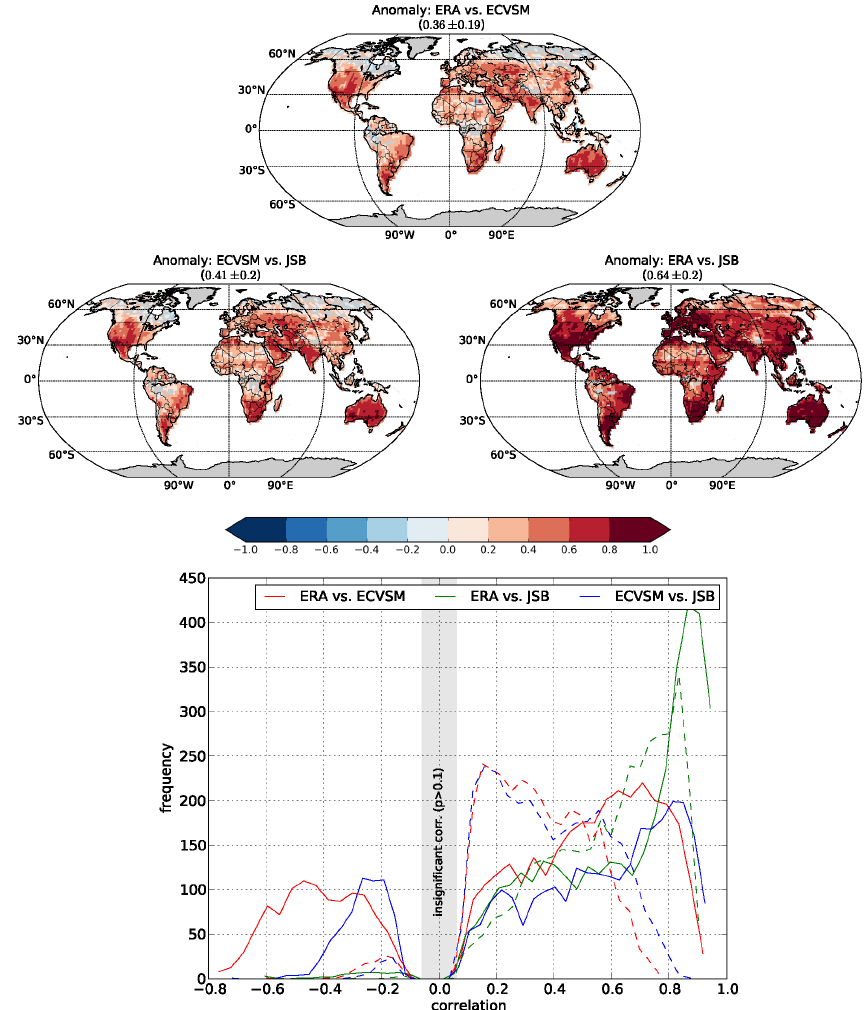
Fig. 4. Correlation coefficient for the linear correlation between the surface soil moisture anomalies: ERA vs. ECVSM, ECVSM vs. JSBACH, ERA vs. JSBACH. Only significant correlations ( p value < 0.1) are shown. Frequency distribution of correlation coefficients between differ- ent datasets is shown in the histogram (solid line: soil moisture data; dashed line: soil moisture